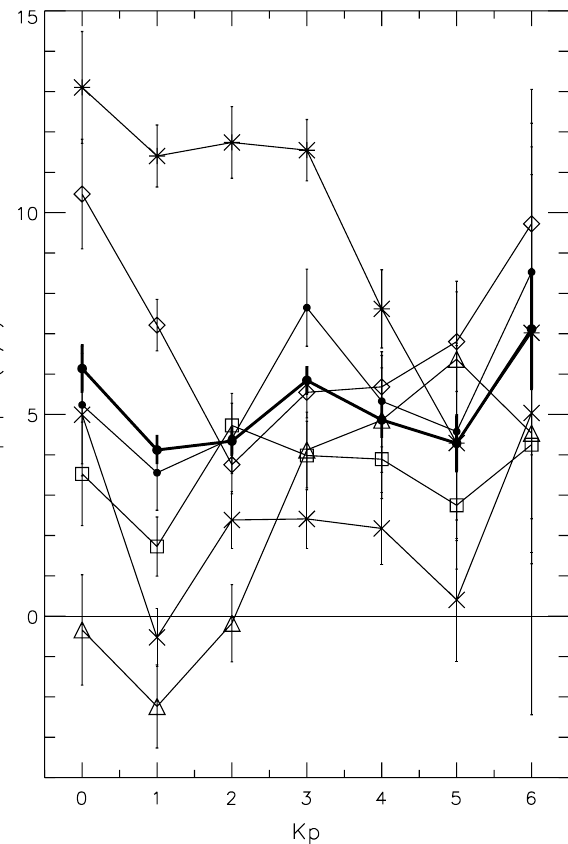
Fig. 7. The same results as Fig. 3 except for all seasons combined.